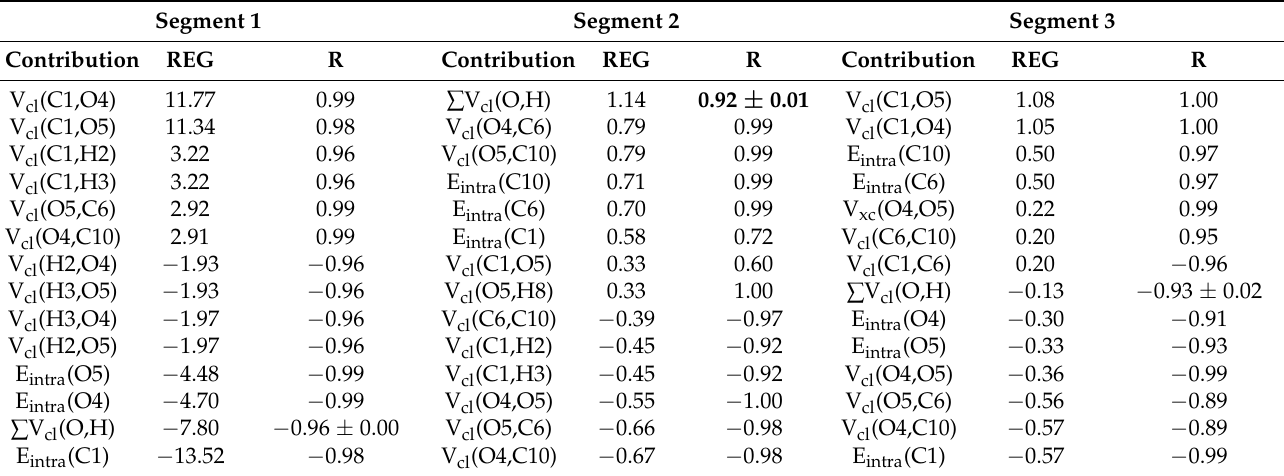
Table 1. Largest magnitude REG values across the three energy segments of DMM along with their Pearson correlation coefficient (R) values. Unacceptably low R values are marked in bold.